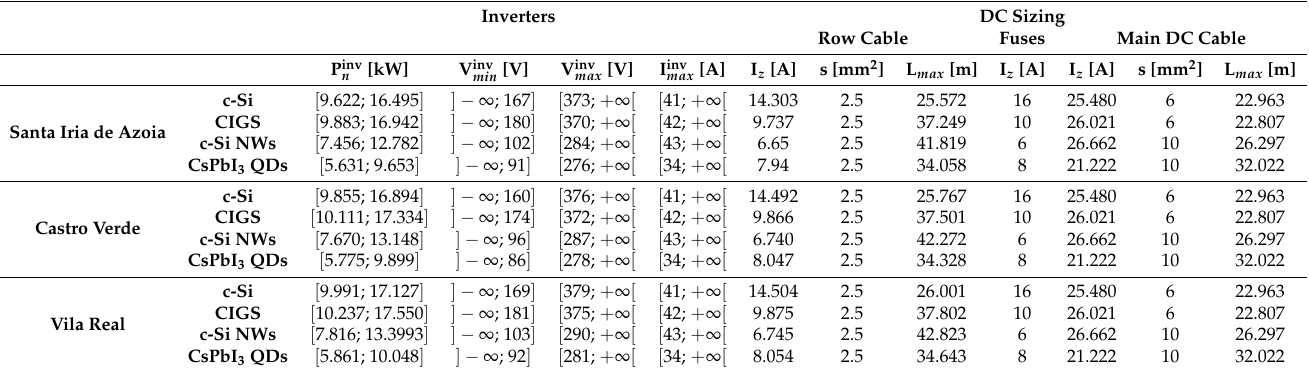
Table 2. Inverters and DC sizing.